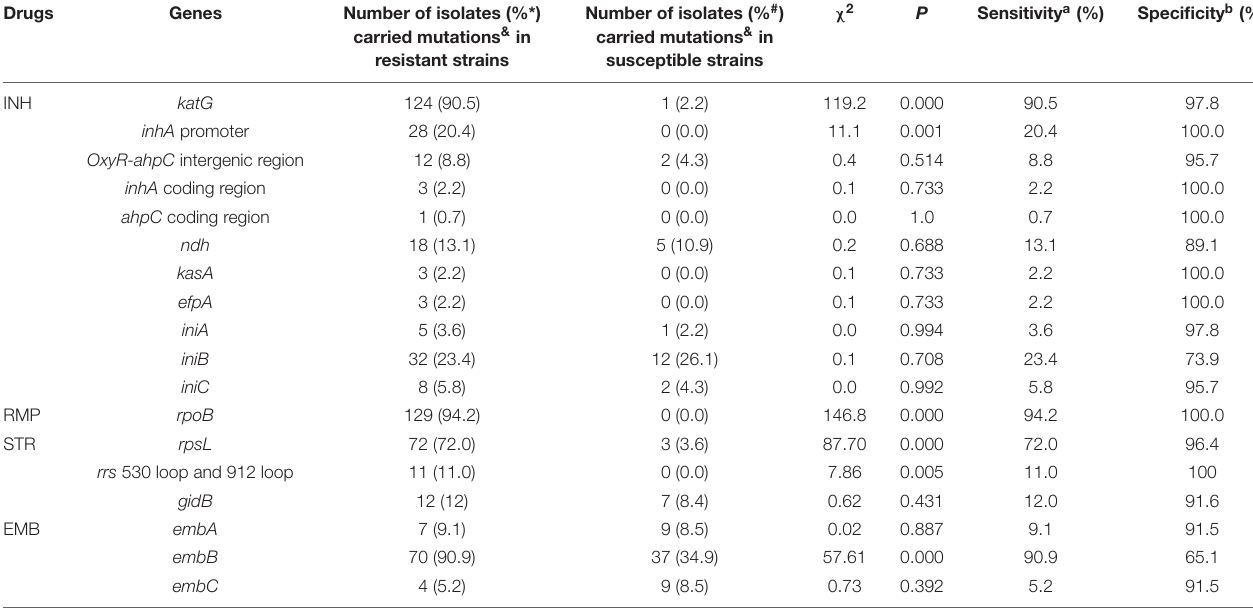
TABLE 3 | The evaluation between whole-genome sequencing analysis of 18 drug-resistant associated genes or regions and the phenotypic drug susceptibility testing. χ 2 P Sensitivity a (%) Specificity b (%) Drugs Genes Number of isolates (%*) Number of isolates (% # ) carried mutations & in carried mutations & in resistant strains susceptible strains INH katG